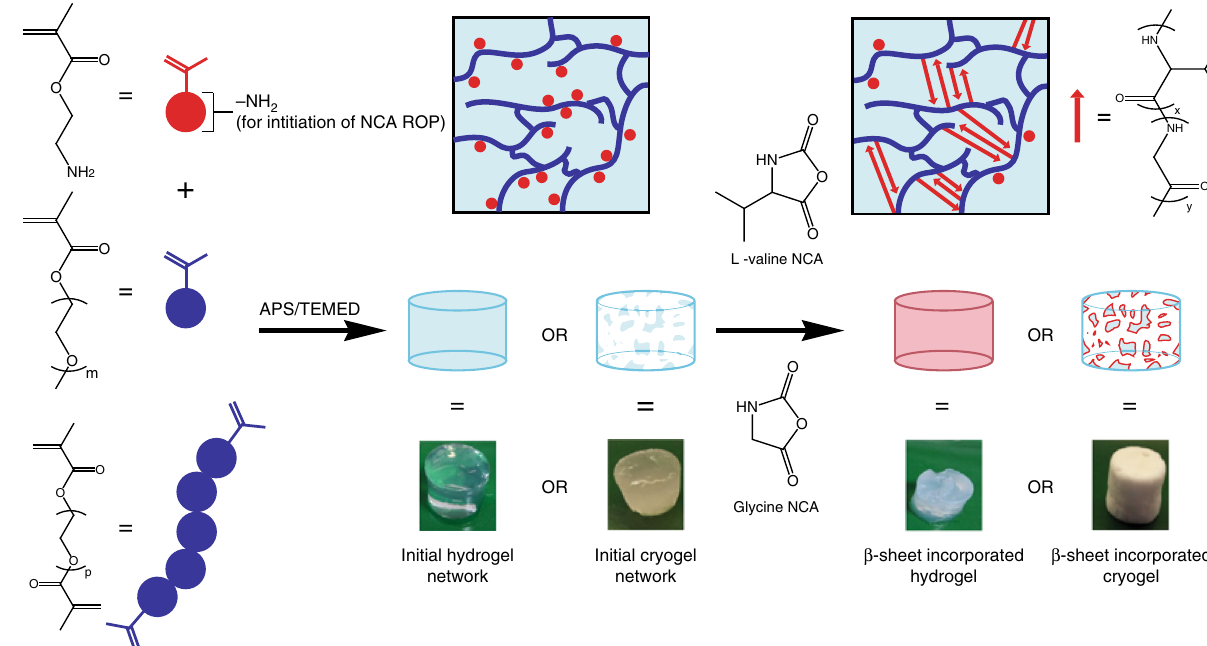
Fig. 1 Fabrication of peptide β – sheets loaded composite networks. Networks synthesised via (i) production of two initial networks (a hydrogel and a cryogel) with pendant primary amine groups by free radical polymerization; and (ii) subsequent ROP of Val NCA initiated by the amine groups on the polymer backbone, resulting in the formation of β -sheet secondary structure within the